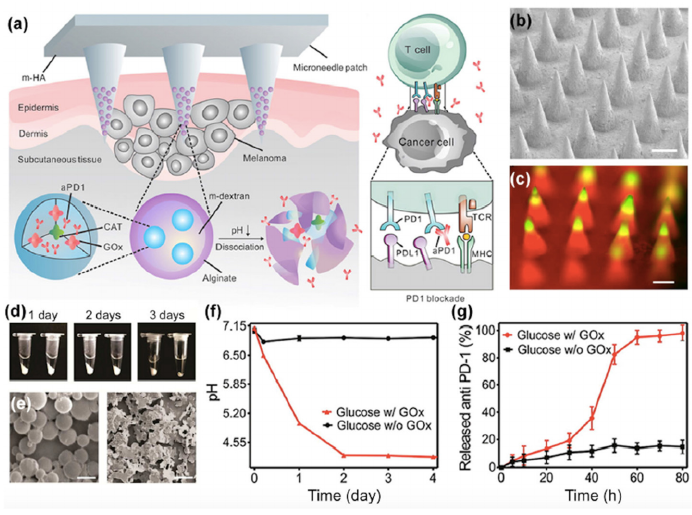
Figure 3. ( a ) Schematic design of the TDDS of the anti-PD1 antibody by the microneedle patch. ( b ) SEM image and ( c ) fluorescence image of the microneedles. ( d ) Appearance and ( e ) SEM images of the anti-PD1 antibody-loaded nanoparticles. ( f , g ) Release profiles of the anti-PD1 antibody from the microneedle in the presence of glucose oxidase. Reprinted with permission from ref 54. Copyright 2016 American Chemical Society.